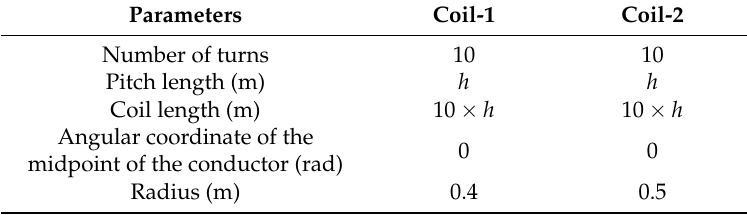
Table 2. Geometric parameters of the coils in Figure 2 (1st comparison).